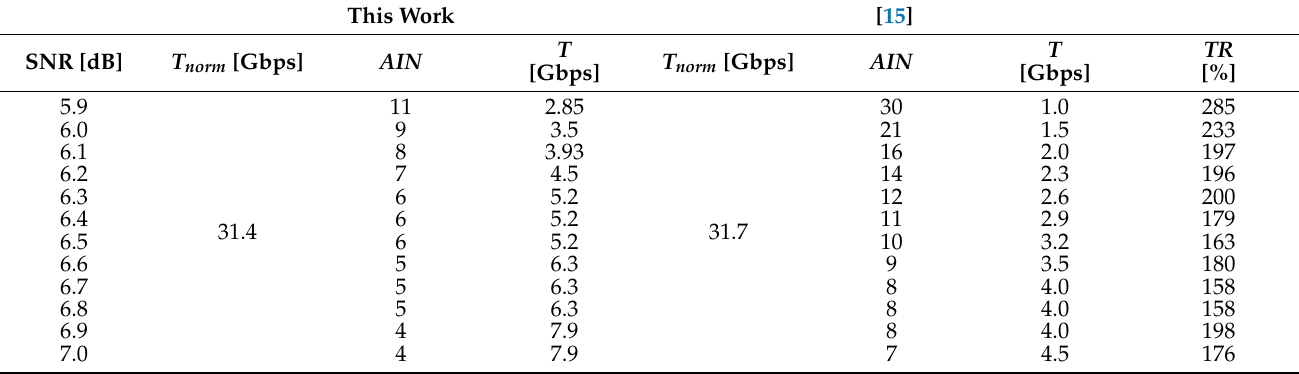
Table 2. Throughput ratio between priority-based layered decoder with double update queues and hybrid layered decoder [15].